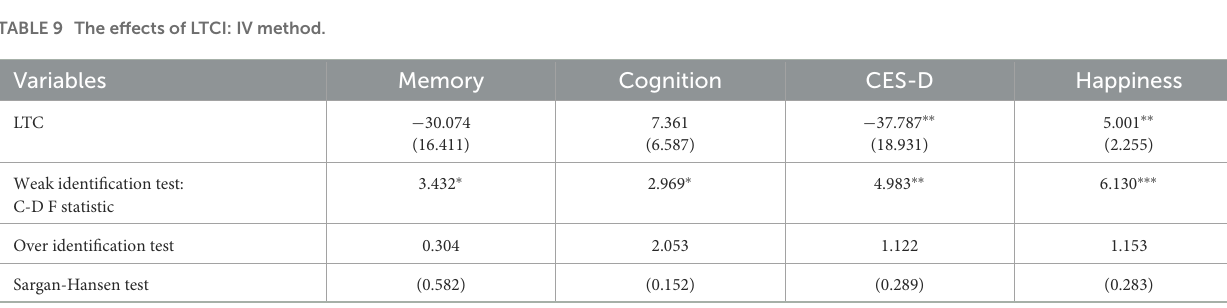
TABLE 9 The effects of LTCI: IV